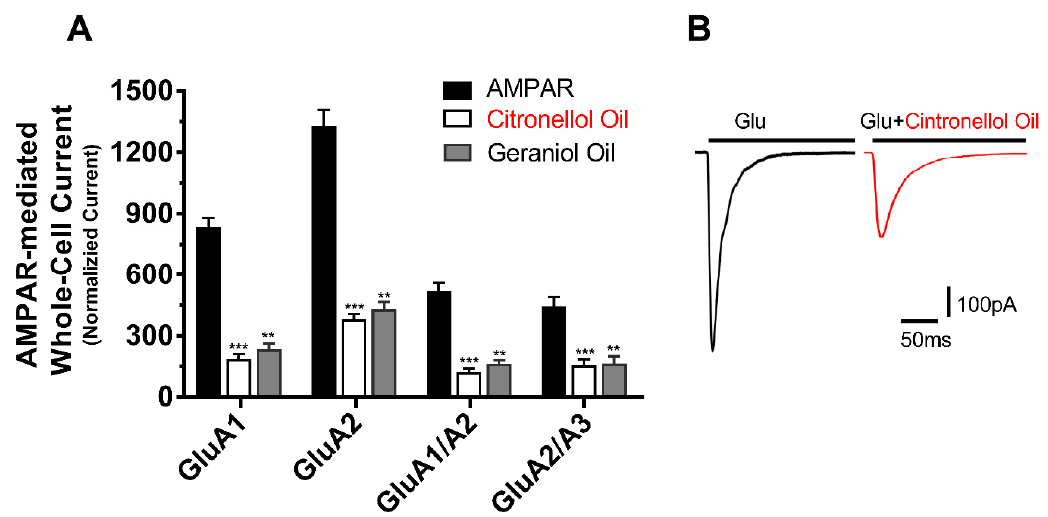
Figure 1. E ff ect of essential oils and compounds on the amplitude of the whole-cell generated by various AMPAR subunits. ( A ). Amplitude generated from glutamate alone (black), glutamate + Citronellol (white) and from glutamate + Geraniol (grey). ( B ). Pair of representative whole-cell current traces from GluA1 channels (most significant) expressed in HEK-293 cells in the absence (left) and presence (right) of Citronellol oil. The recording was conducted upon 500 ms application of 10 mM glutamate to whole-cell recording from HEK293 cells expressing various AMPARs subunits.